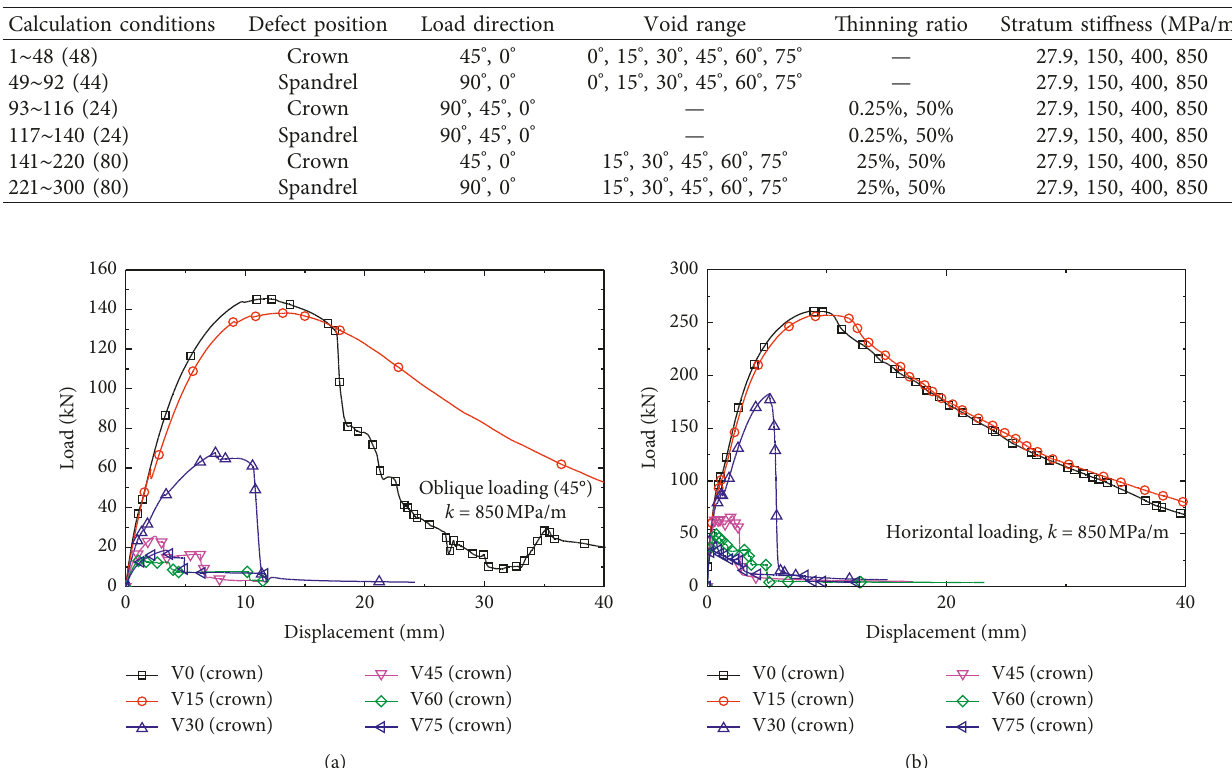
Figure 8: Load-displacement cure of the lining under crown voids. (a) 45 ° oblique loading. (b) Horizontal loading.